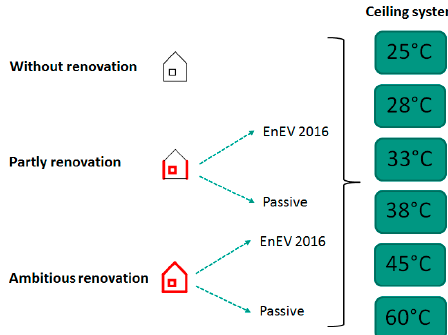
Figure 2. Presentation of all the considered renovation ( left ) and heating ( right ) scenarios for transient simulations.